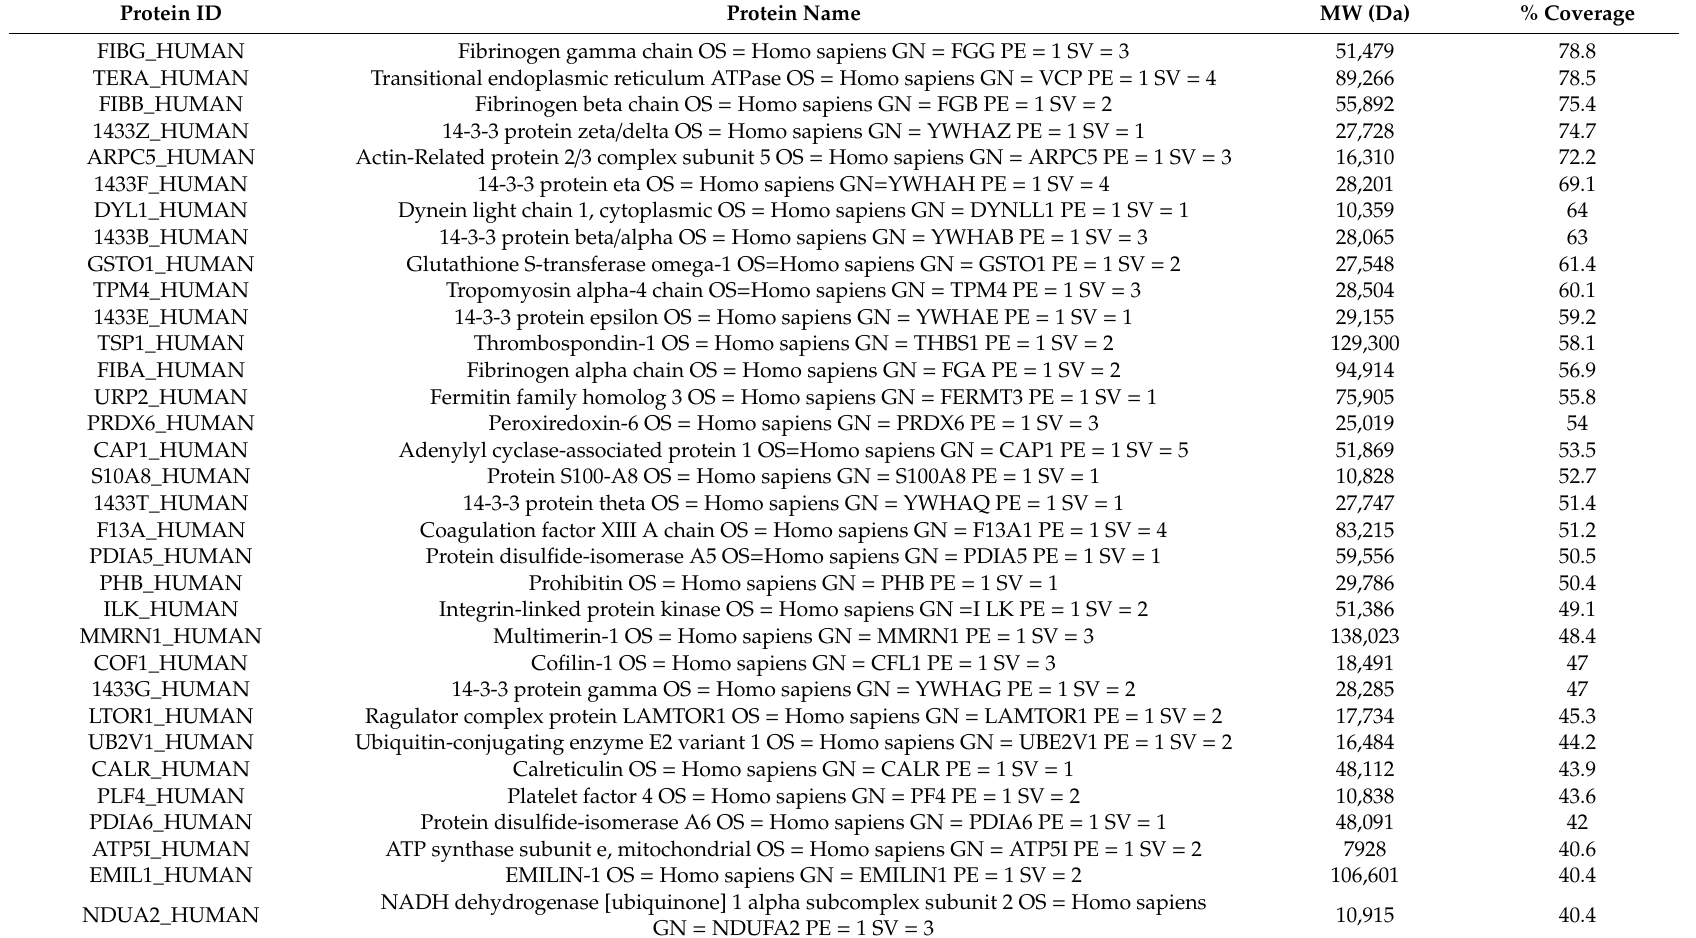
Table 1. Identification of Parkin-interacting proteins in DM platelets (above 40%